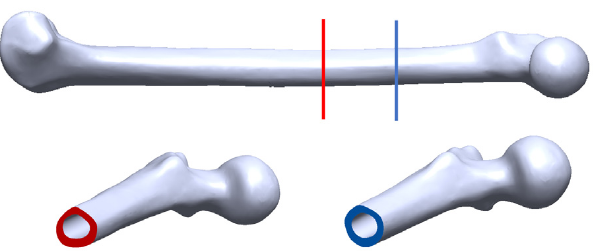
Figure 2. 3D femur model demonstrating the triangular and oval cross–section for different